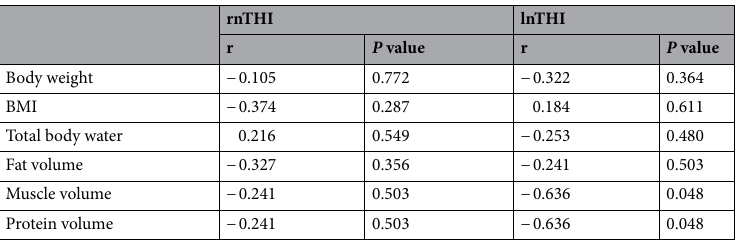
Table 3. Correlation between rnTHI 3 or lnTHI 3 and items in body composition analysis in patients with dementia. Abbreviations: rnTHI: right normalized tissue hemoglobin index, lnTHI: left normalized tissue hemoglobin index, BMI: body mass